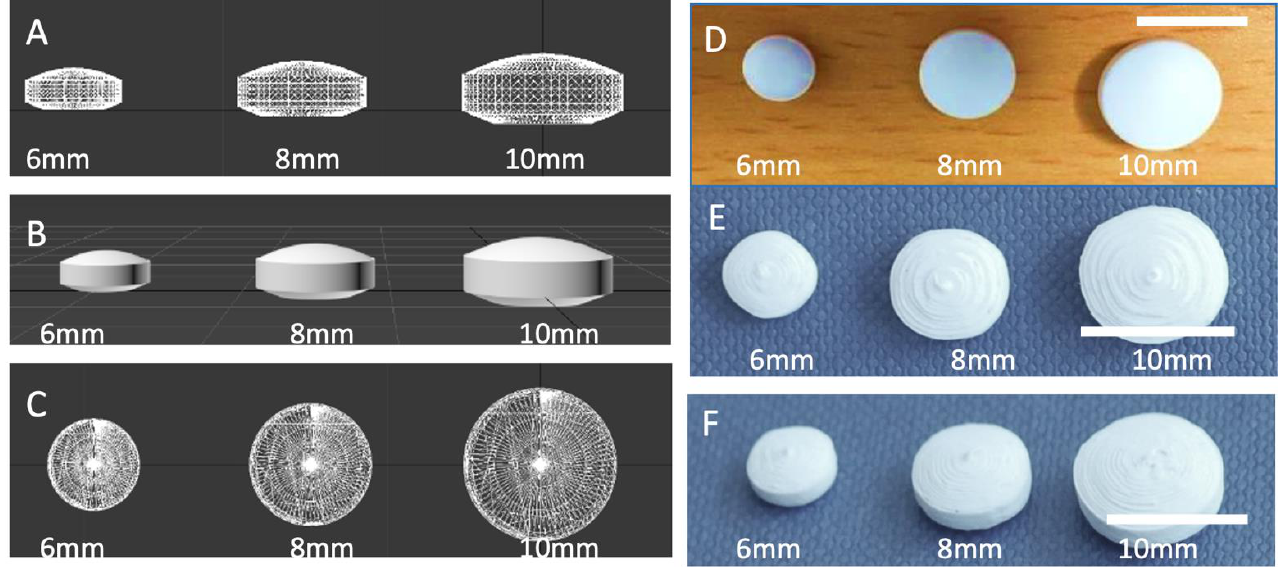
Figure 2. ( A ) Side and ( B ) upper view of a lattice image and ( C ) rendered image of CAD design of convex tablets with three different sizes; ( D ) photograph of film-coated tablets, photographs of ( E ) top and ( F ) view of 3D printed tablets.